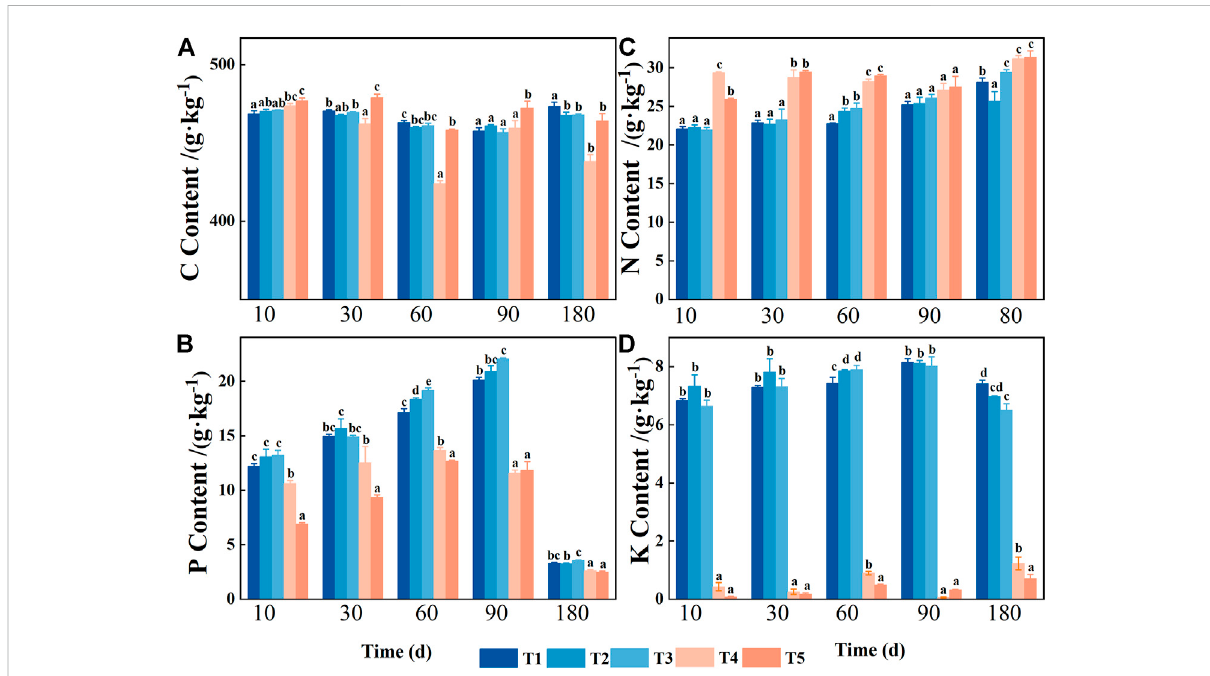
FIGURE 2 Variations in foliar nutrients during decomposition in the Three Gorges Reservoir, China: Leaf carbon content (C) in (A) ; Leaf phosphorus content (P) in (B) ; Leaf nitrogen content (N) in (C) ; and Leaf potassium content (K) in (D) . T1 stands for conventional water treatment [control check (CK)], T2 stands for mild drought stress, T3 stands for saturated water content, T4 stands for light fl ooding stress, and T5 stands for severe water fl ooding stress. At the 0.05 level, different letters show signi fi cant differences between treatments at the same